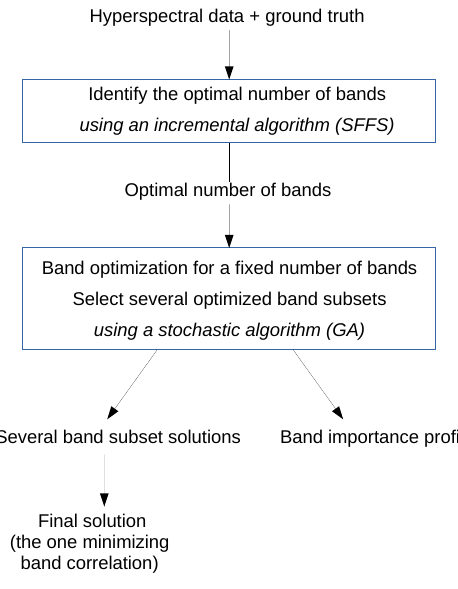
Figure 1: Proposed feature selection